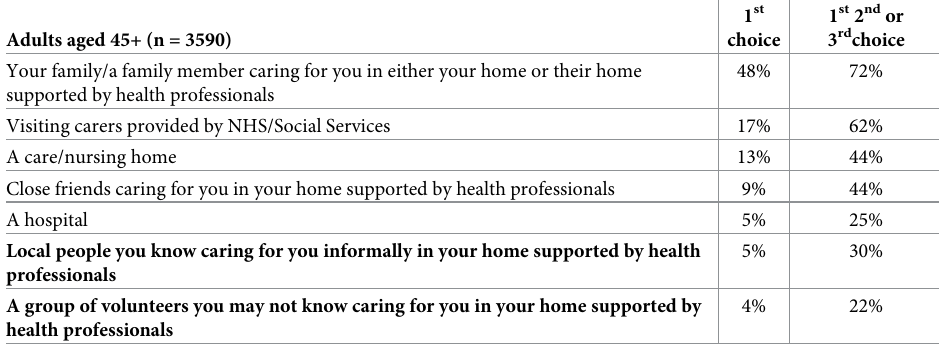
Table 7. Preference for type of care should the need